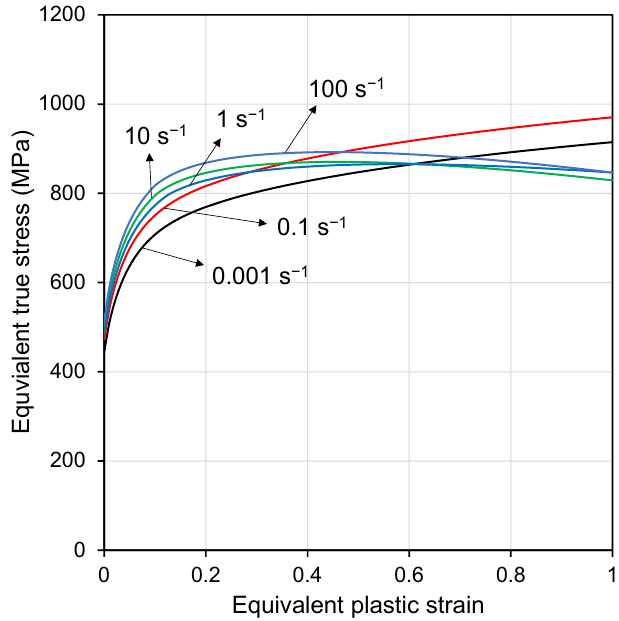
Figure 5. Flow stress curves at various strain rates.